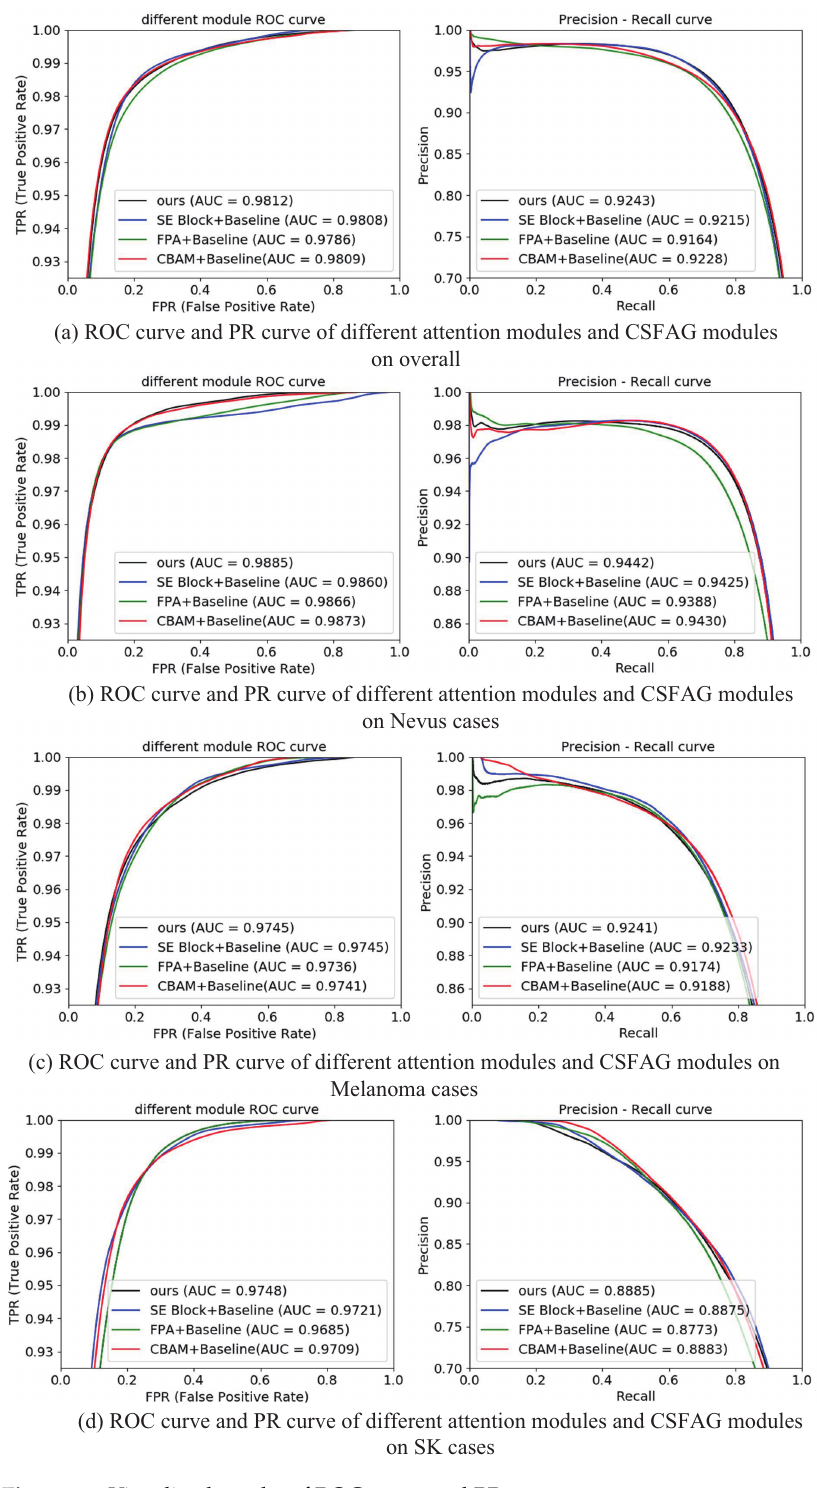
Figure 10. Visualized results of ROC curve and PR